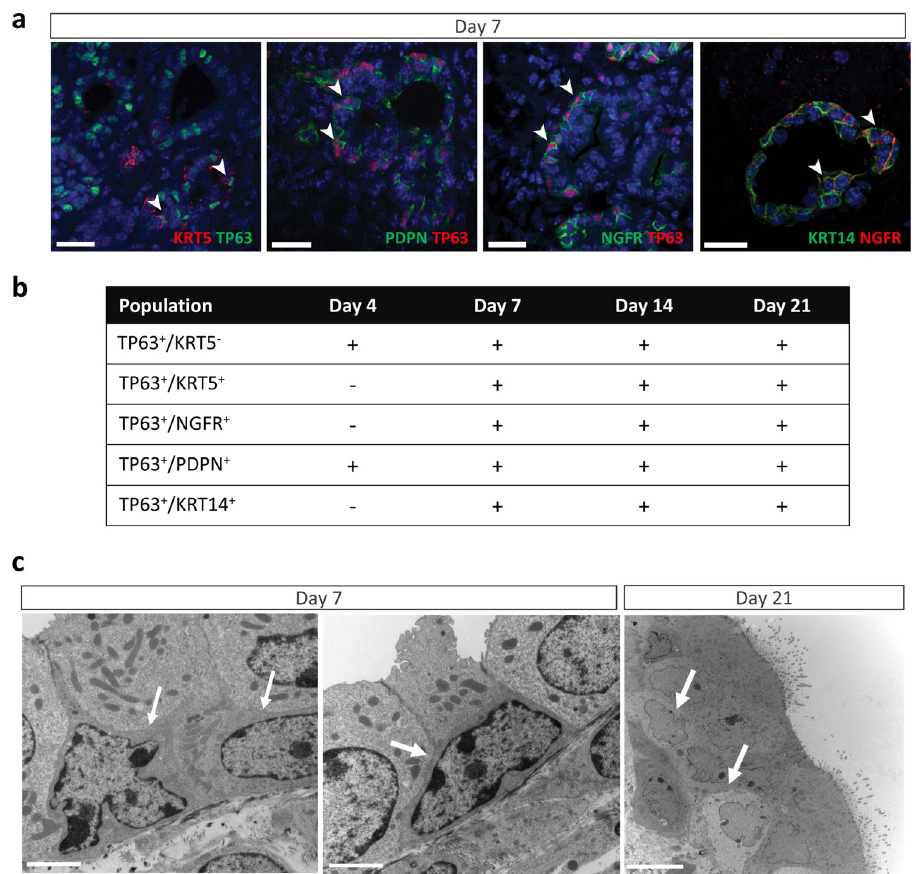
Fig. 2 Identi fi cation of basal cells on decellularized lung scaffolds seeded with de fi nitive endoderm (DE) cells. a Representative immuno fl uorescence confocal images of DE cells on acellular lung scaffolds after 7 days of culture co-stained for a combination of basal lineage cell markers (arrow heads) including TP63 (tumor protein p63), KRT5 (keratin 5), KRT14 (keratin 14), PNDP (podoplanin) and NGFR (nerve growth factor receptor). Scale bar: 25 μ m. b Table summarizing different combinations of basal cell markers detected between 4 and 21 days of culture. “ + ” : detected, “ − ” : not detected. c Representative TEM images of basal cells (arrow) at day 7 and 21 of culture of DE cells on acellular lung scaffolds. Scale bar: 2 μ m (Day 7), 10 μ m (Day